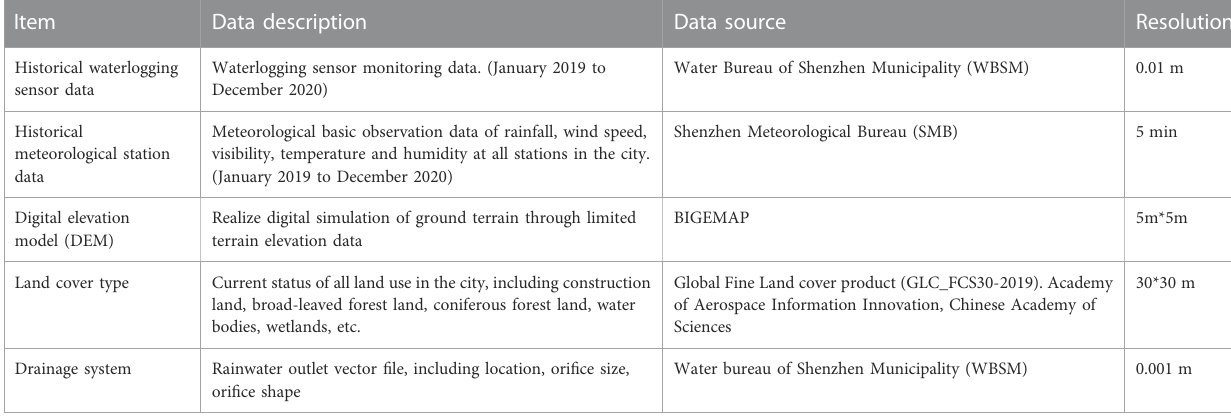
TABLE 2 Data description and